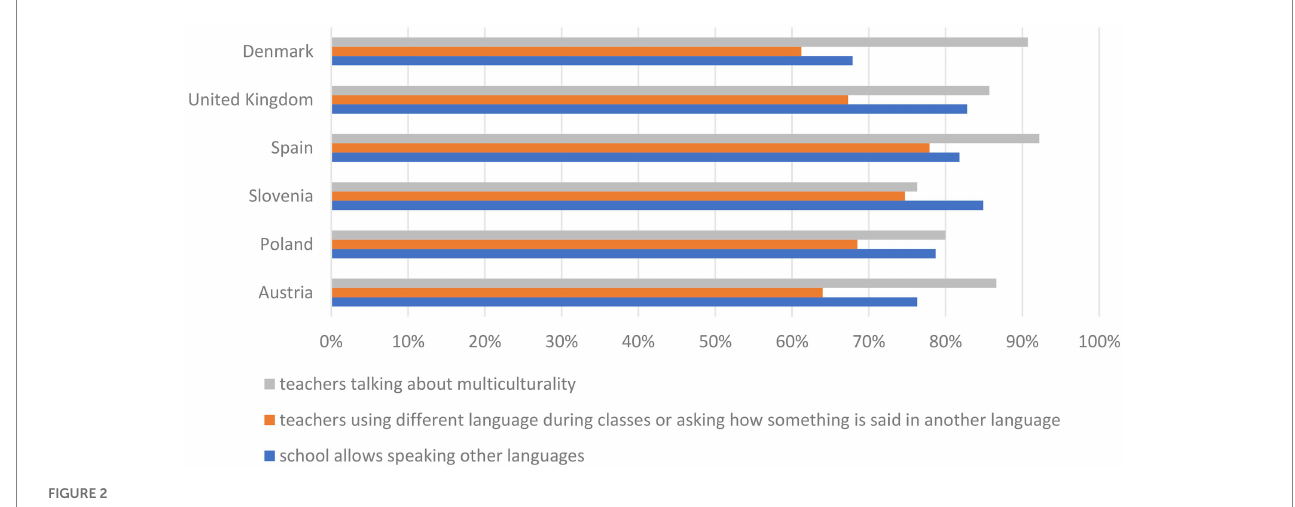
FIGURE 2 Prevalence of tools of intercultural education by country.